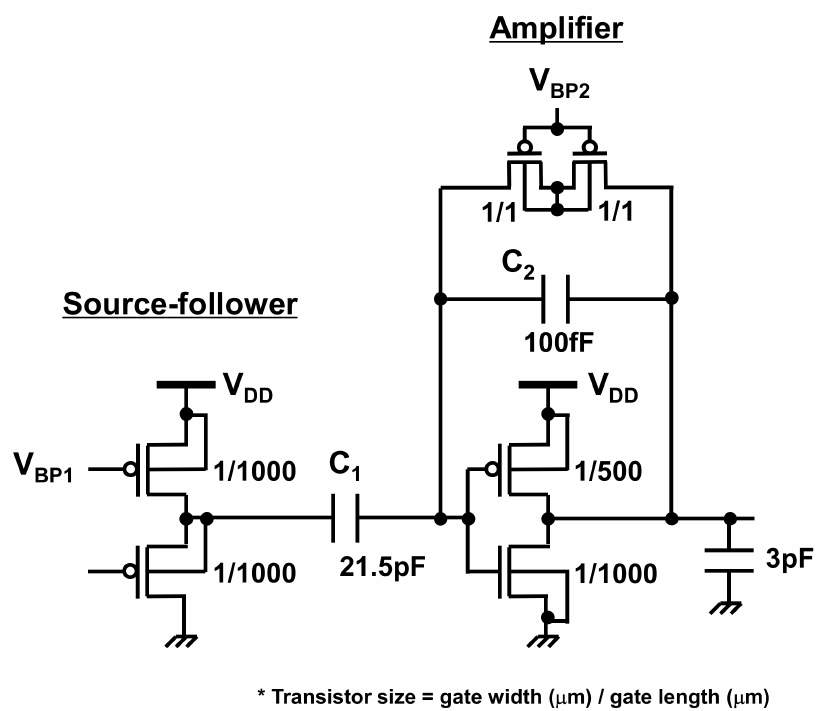
Figure 4. Circuit schematic of the front-end amplifier used in the proposed gesture recognition chip (Figure 1). The front-end amplifier consists of a source follower with an inverter-based amplifier.